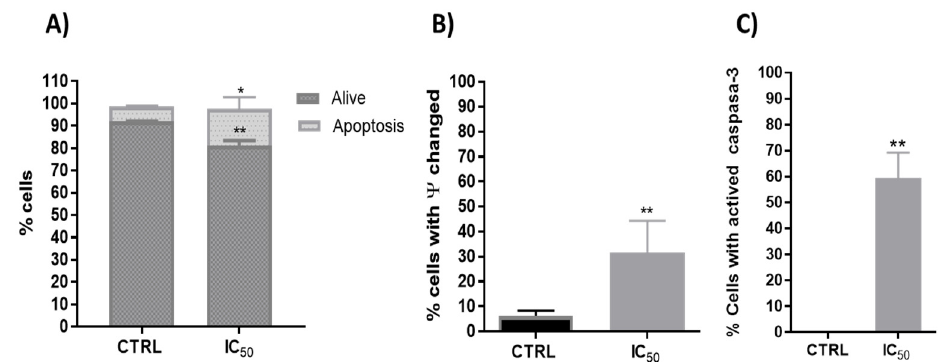
Figure 4. ( A ). Percentage of the type of cell death induced on Caco-2 cells after 48 h incubation in CTRL (untreated cells) and onion extract at IC 50 (1000 µg/mL) * p < 0.05; ** p < 0.01. ( B ). Analysis of mitochondrial membrane potential ( ∆ψ m) after 48 h incubation with onion extract at IC 50 ** p < 0.01 vs. CTRL. ( C ). Percentage of Caco-2 cells with presence of active caspase-3 after 48 h incubation with onion extract at IC 50 ** p < 0.01 vs. CTRL.